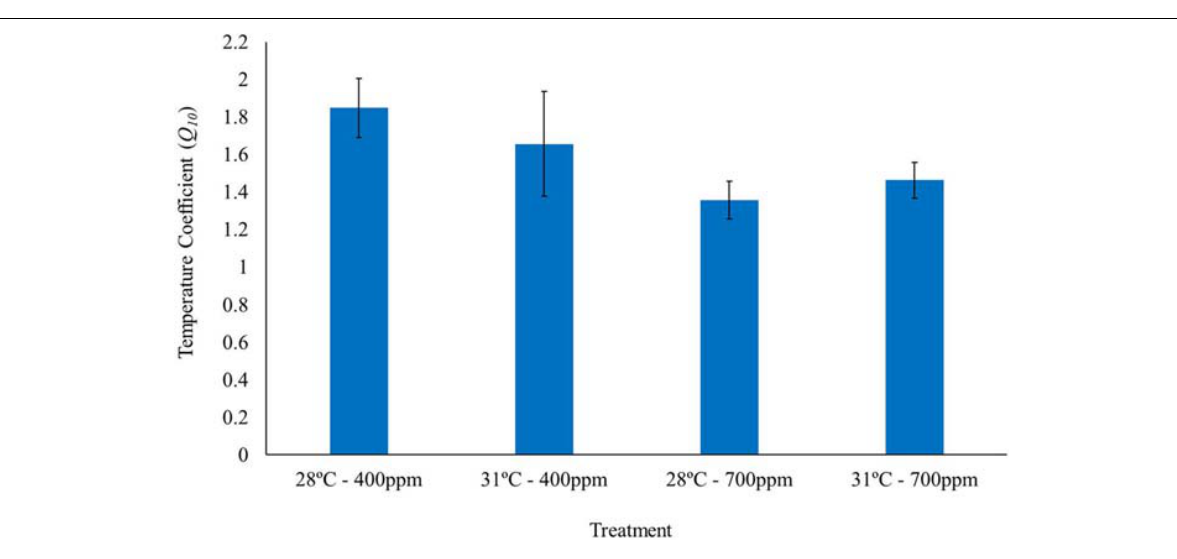
FIGURE 2 | Temperature coefficients ( Q 10 ) of gastropods acclimated to different temperatures (28 and 31 ◦ C) and CO 2 concentrations (400 and 700 ppm) ( n = 15). Temperature coefficient values were calculated for each individual gastropod, as the respiration rate at 10 ◦ C below and up to the corresponding T MMR for that treatment. Bars represent mean Q 10 of all individuals in the given treatment ± standard